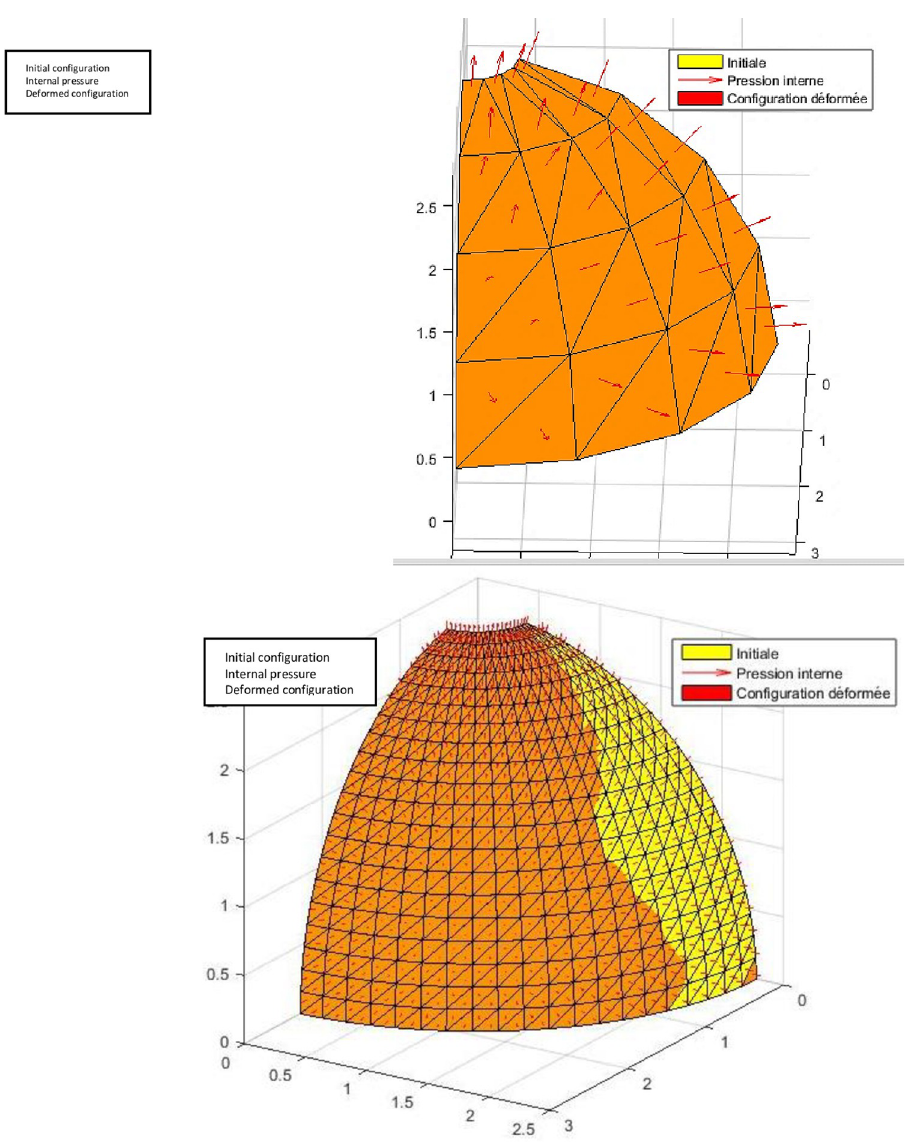
Fig 17. Isometric view of the deformed configuration of ¼ of the sphere (meshes 4 × 4 and 20 × 20).